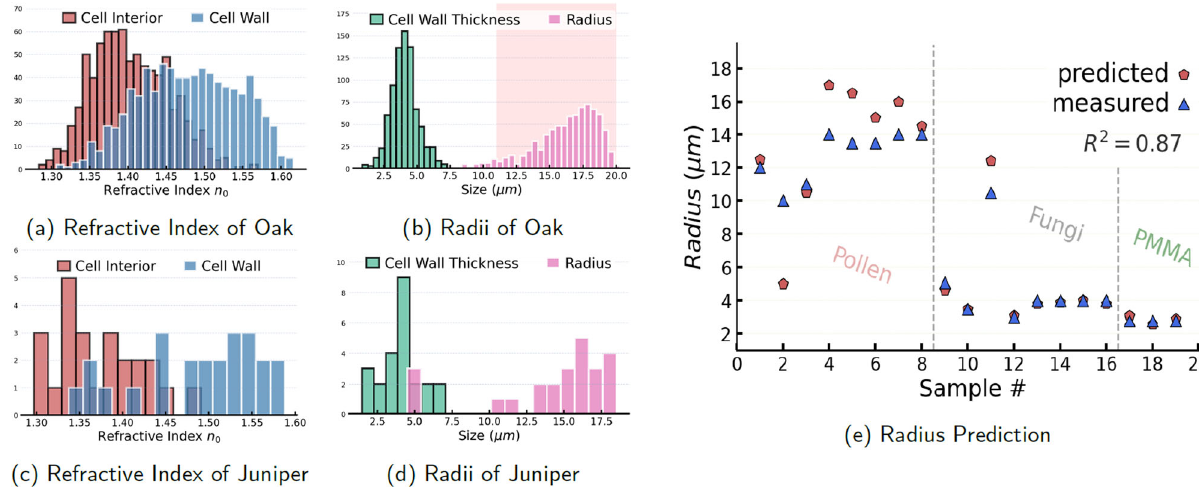
Fig. 5 Predictions of morphology and effective refractive index. a Predicted refractive indices for 800 spectra of oak pollen grains. b The predicted sizes of the oak pollen grains and their cell wall thicknesses. The sizes given in the literature are marked with a pink background in the histogram. c Predicted refractive indices for 24 spectra of juniper pollen grains and in d their predicted sizes. e Comparison of the radii predicted from our model and those measured from light microscopy images. We show data from three different sample types, namely juniper pollen grains, fungal cells, and PMMA